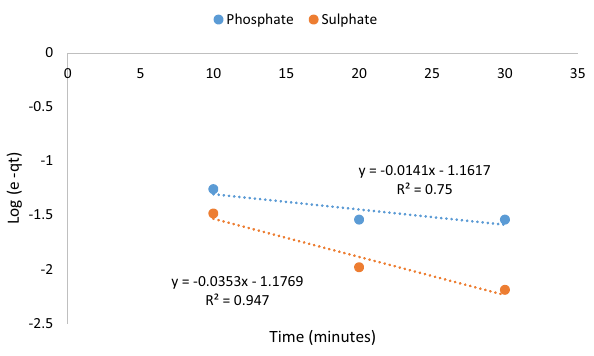
Fig. 4 A pseudo-first order kinetic model of phosphate nd sul- phates onto acid washed copper smelter slag